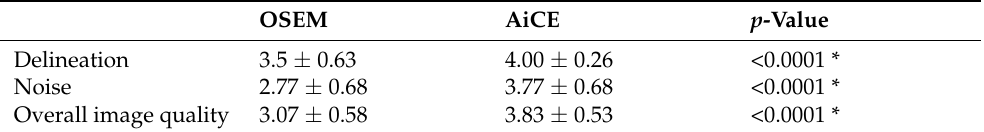
Table 2. Qualitative image